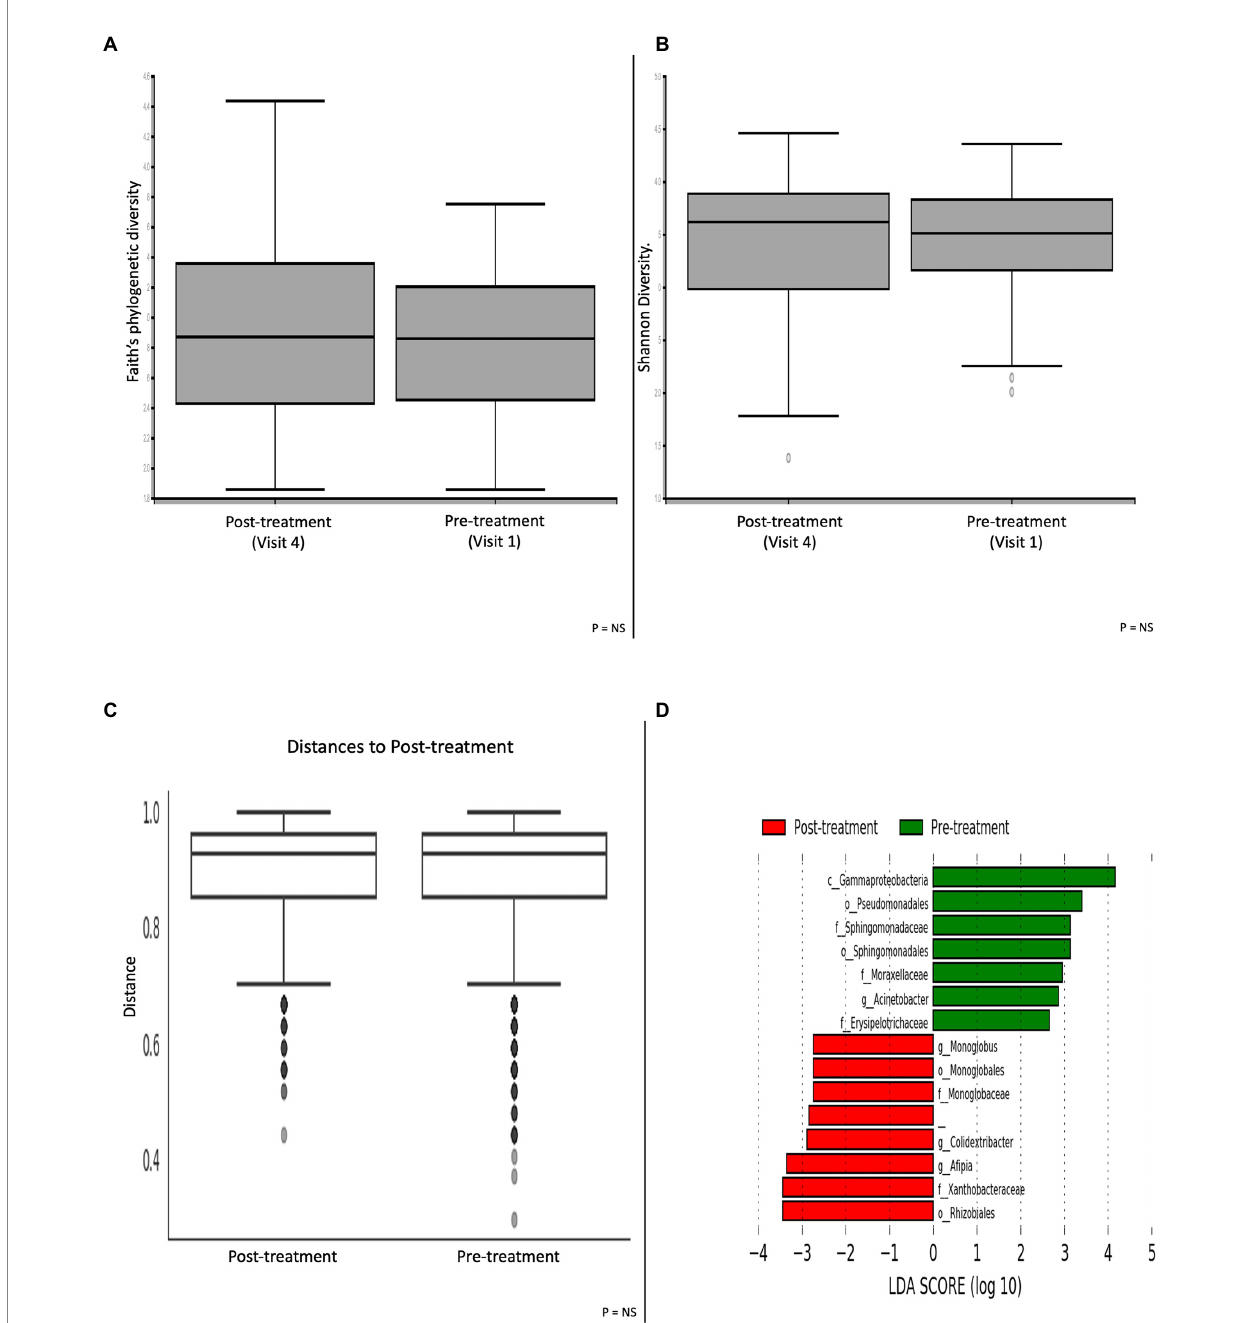
FIGURE 4 Microbial differences comparing patients pre-and post-treatment with the bile acid sequestrant colesevelam. α -diversity metric (A) Faith’s phylogenetic diversity and (B) Shannon diversity. (C) β -diversity Bray-Curtis distance matrix metric. (D) LEfSE histogram of LDA scores for differentially abundant bacterial taxa between pre-and post-treatment patients. Taxa highlighted in green was more significant in pre-treatment patients and red in post- treatment patients. Taxa with an LDA >2 with a p -value ≤ 0.05 was considered statistically